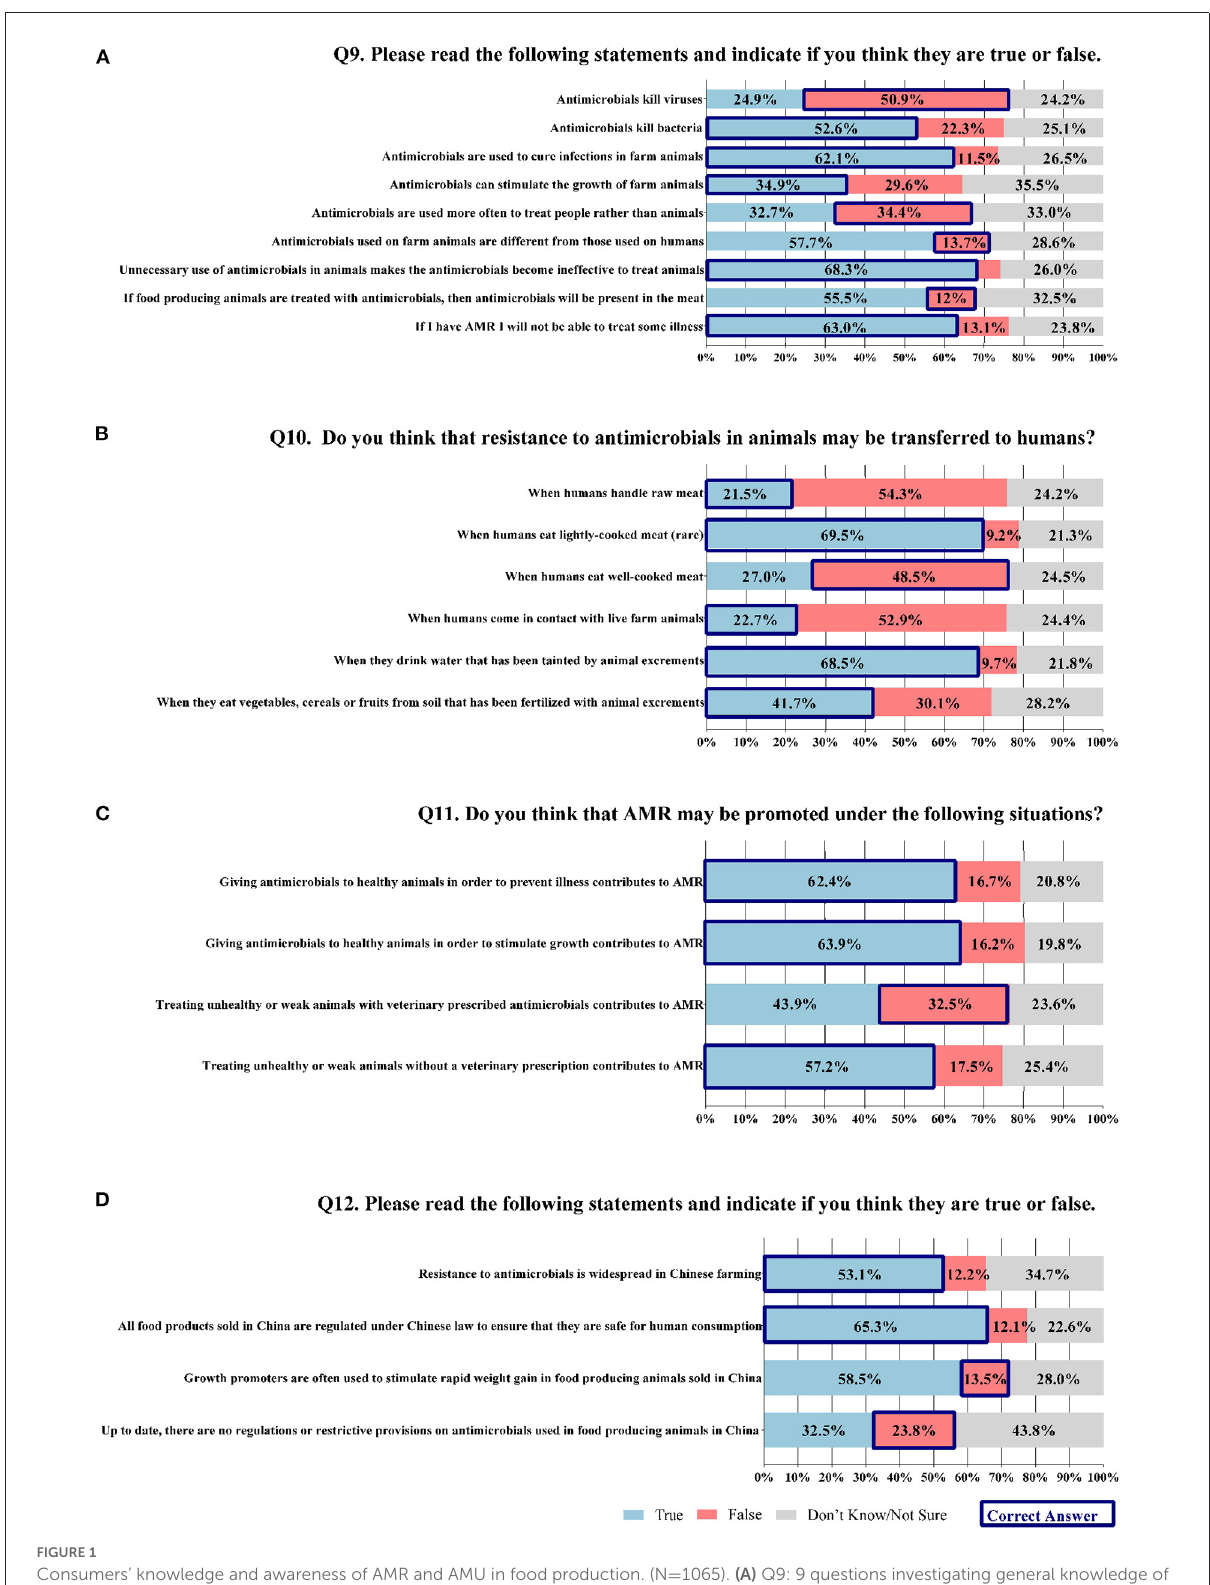
FIGURE1 Consumers’ knowledge and awareness of AMR and AMU in food production. (N = 1065). (A) Q9: 9 questions investigating general knowledge of AMR and AMU in food production. (B) Q10: 6 questions assessing knowledge of how resistant bacteria transferred from animals to humans. (C) Q11: 4 questions measuring knowledge of how AMR may be promoted. (D) Q12: 4 questions evaluating knowledge and awareness of current situation in